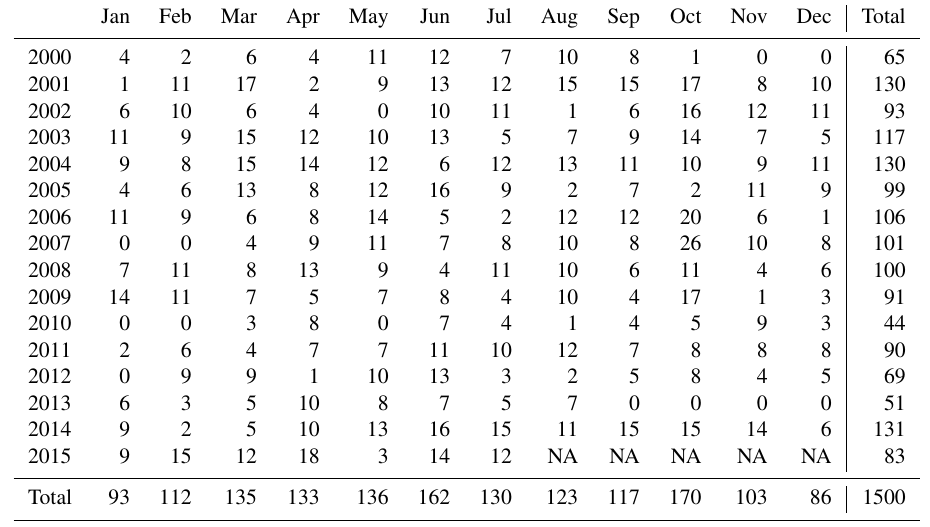
Table 1. Number of measurements, by month and years, performed at TMF with the tropospheric ozone DIAL system. NA indicates data not available at the time of the study.